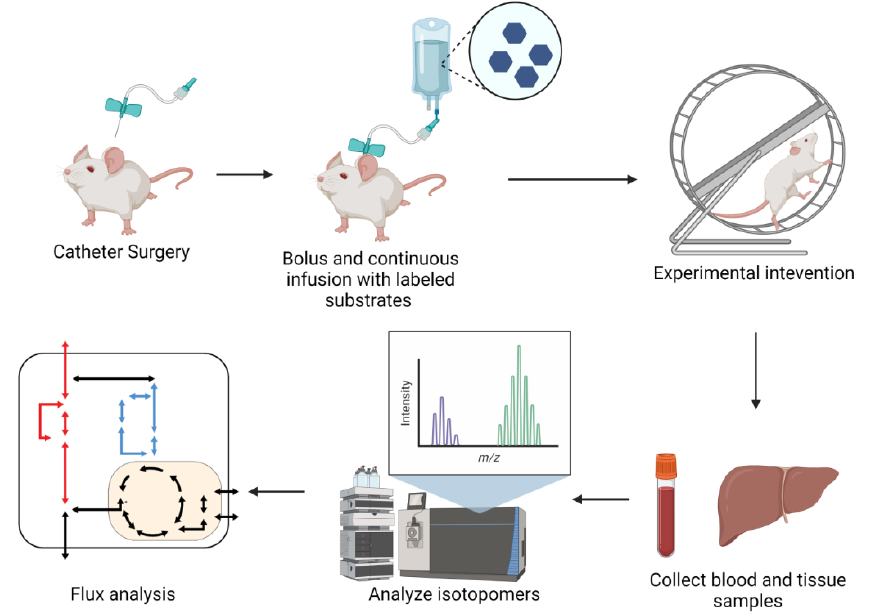
Figure 5. Schematic of in vivo experimental procedures. Schematic of typical in vivo iMFA experi- mental workflow. Protocols typically begin with catheterization surgeries. Following recovery, mice are provided with bolus of stable isotope substrates and subjected to experimental procedure until metabolites achieve isotopic steady state. Blood and tissue samples are collected for analysis with NMR or MS. Isotopomer data is regressed with iMFA software to quantify metabolic fluxes. Figure created with BioRender.